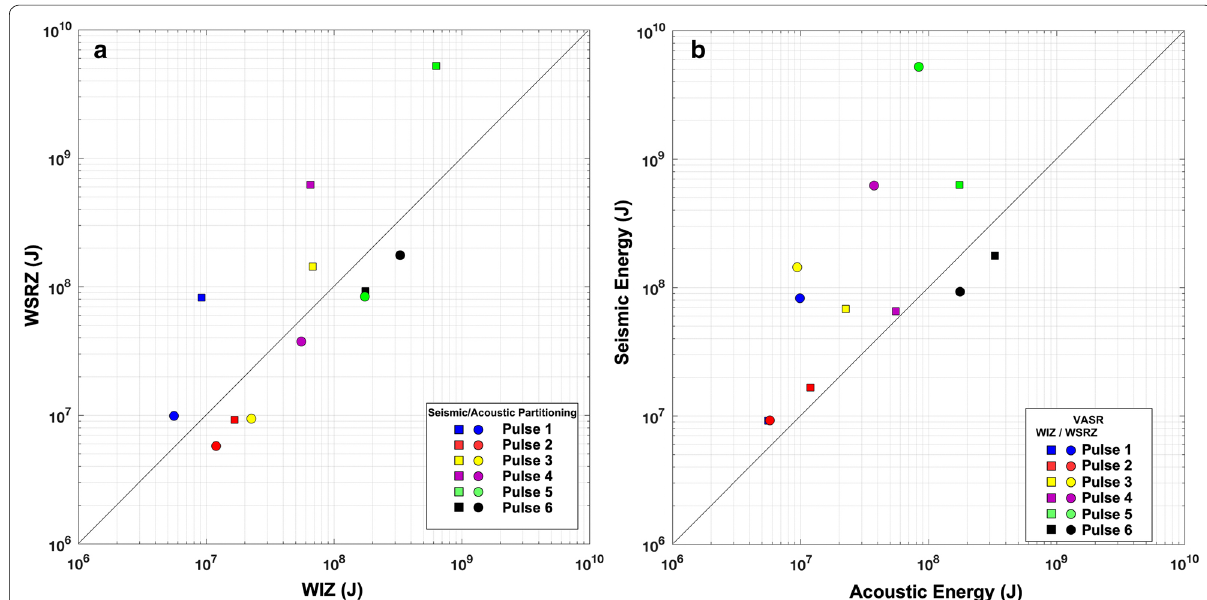
Fig. 11 a Energy partitioning between stations WIZ and WSRZ for acoustic data (circles) and seismic data (squares). b VASRs between stations WIZ (squares) and WSRZ (circles) for all six eruptive pulses. The colors of the points represent the different eruptive pulses. The energies are estimated by computing over the whole length of the eruptive